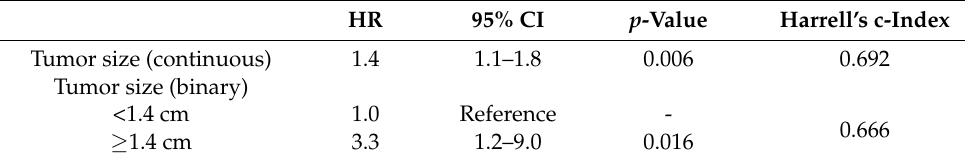
Table 6. Univariable Cox proportional hazards regression analysis for tumor